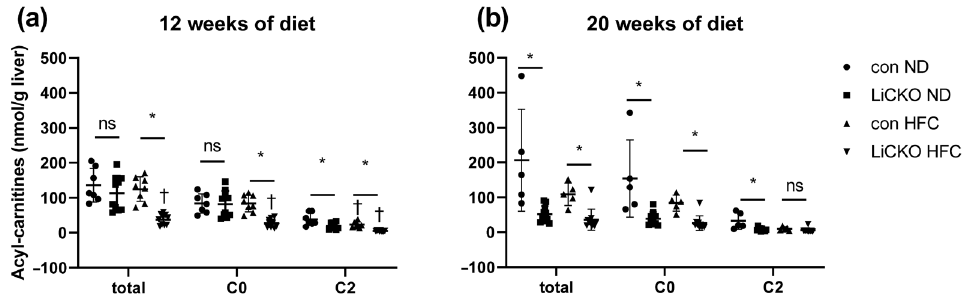
Figure 6. Acylcarnitines in liver. ( a ) Acylcarnitines at 12 weeks of diet; ( b ) Acylcarnitines at 20 weeks of diet; * p < 0.05 difference between con and LiCKO on same diet; † p < 0.05 difference between ND and HFC for con or LiCKO; ns = non-significant.